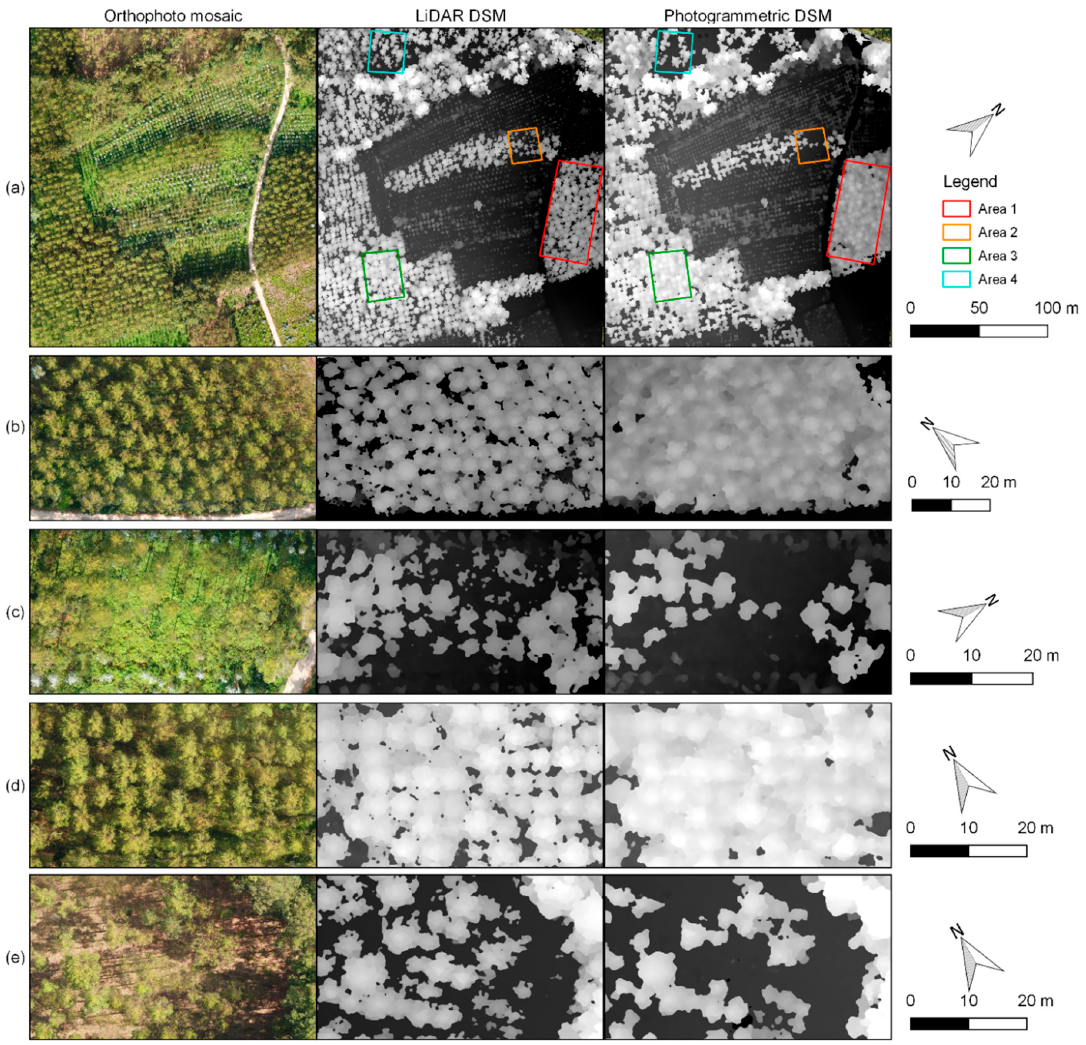
Figure 6. Digital surface models (DSMs) driven from LiDAR (centre) data and through photogrammetric processing (right) of RGB imagery in the same area. Orthophoto mosaic for visual interpretation (left); general overview of the area ( a ); and close views of the areas 1, 2, 3, and 4 ( b , c , d , e ). Data courtesy of Aeromedia.